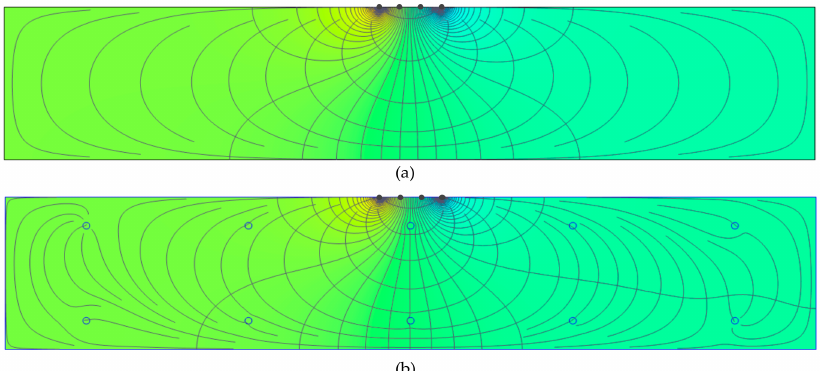
Figure 9. Electric potential field and equipotential distribution in the middle section concrete slab models: ( a ) plain concrete model and ( b ) reinforced concrete model.